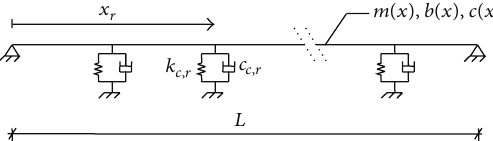
Figure 1: Analytical model for PRSI